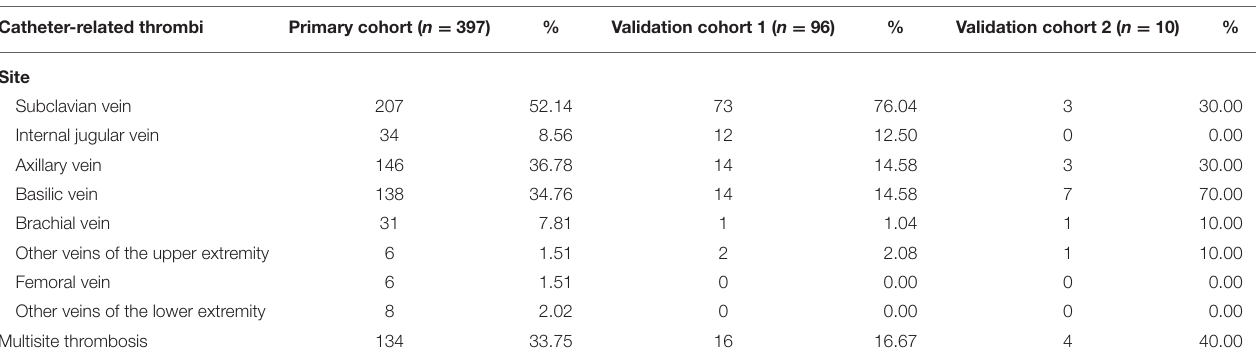
TABLE 2 | Catheter-related thrombi in the primary and validation cohorts. Catheter-related thrombi